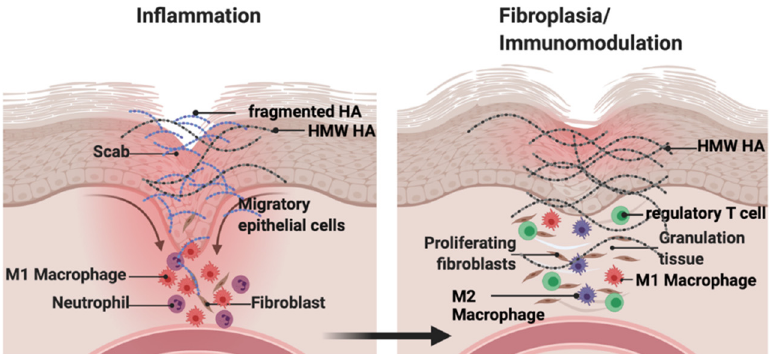
Figure 1. Hyaluronan contributes to inflammation and resolution of excisional wounds. Native (high molecular weight, HMW–HA) hyaluronan production is increased upon and throughout tissue injury. Low molecular weight (LMW–HA) and oligosaccharide (O–HA) fragments are rapidly generated from HMW–HA hyaluronidases and ROS/NOS, resulting in a mixture of HMW and fragmented HA polymers. LMW– and O–HA promote macrophage and fibroblast influx into the wound that initiate inflammation while HMW–HA restrains the extent of inflammation. At later stages of wound repair, HMW–HA predominates and supports macrophage polarization into the immunosuppressive M2 phenotype. Created with BioRender.com (accessed on 12 September 2021).